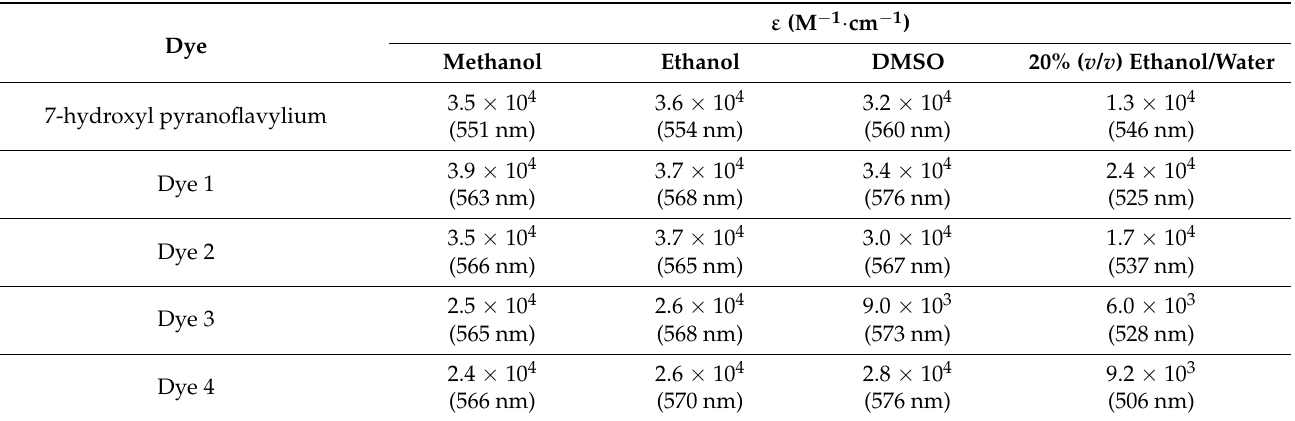
Table 2. Molar absorption coefficients ( ε ) of all new esters in four different solvents (methanol, ethanol, DMSO, and 20% ( v / v ) ethanol/water). Counter-ion: chloride.